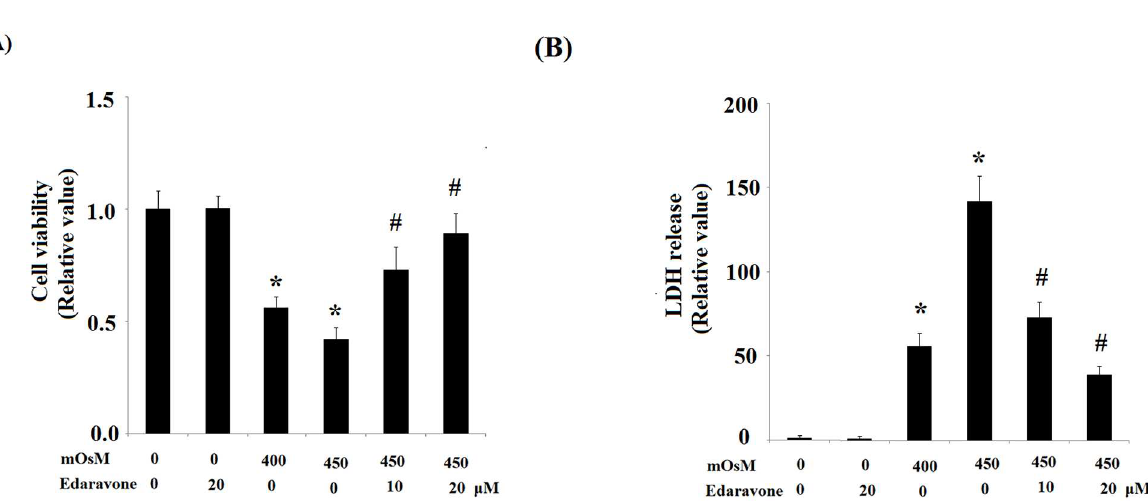
PLOS ONE | https://doi.org/10.1371/journal.pone.0174437 March 27,